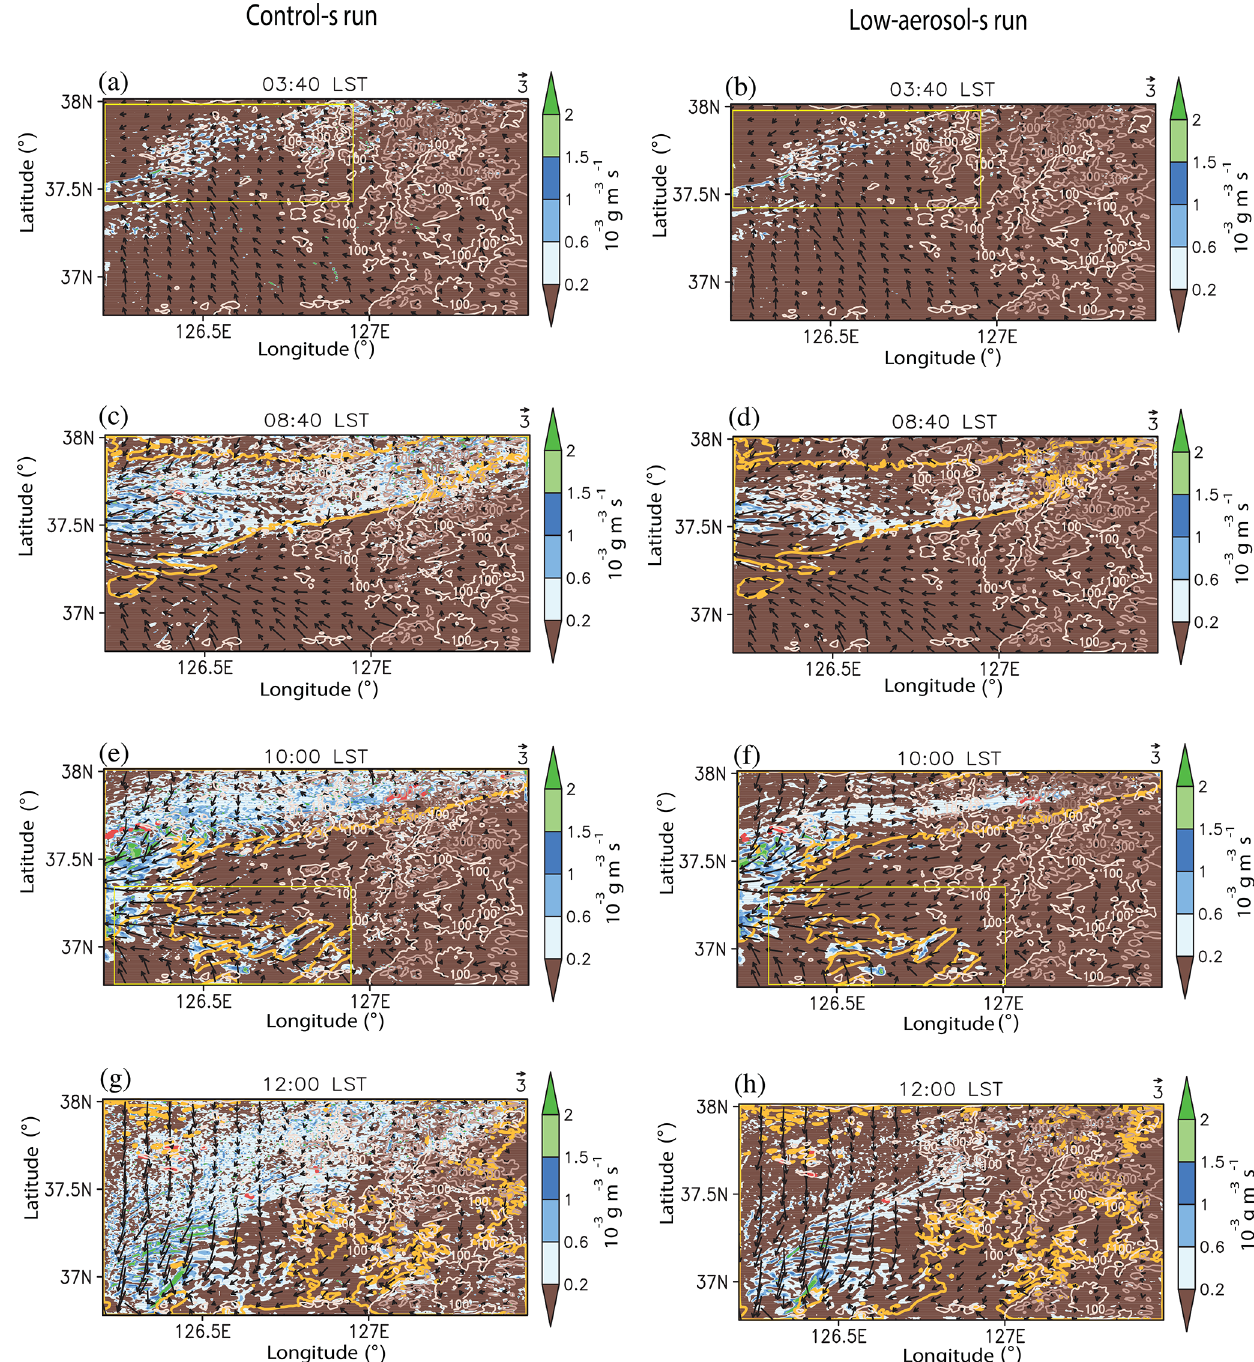
Figure 7. Spatial distributions of terrain heights, column-averaged condensation rates, surface wind vectors and precipitation rates at (a, b) 03:40LST, (c, d) 08:40LST, (e, f) 10:00LST, and (g, h) 12:00LST. The distributions in the control-s run are shown in (a, c, e, g) , and the distributions in the low-aerosol-s run are shown in (b, d, f, h) . Condensation rates are shaded. Dark yellow and dark red contours represent precipitation rates at 0.5 and 3.0mmh − 1 , respectively, while beige, light brown and brown contours represent terrain heights at 100, 300 and 600m, respectively. See text for yellow rectangles in a, b, e,